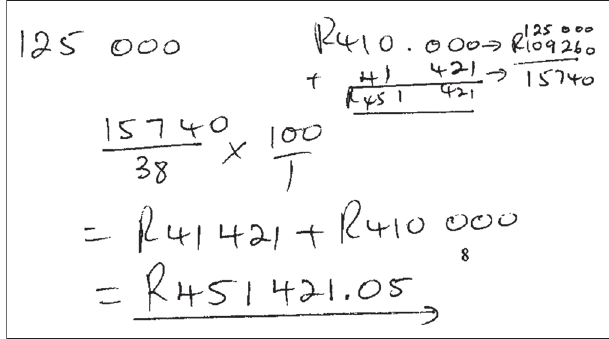
FIGURE 8: Response of MEW 713 to Task 3.